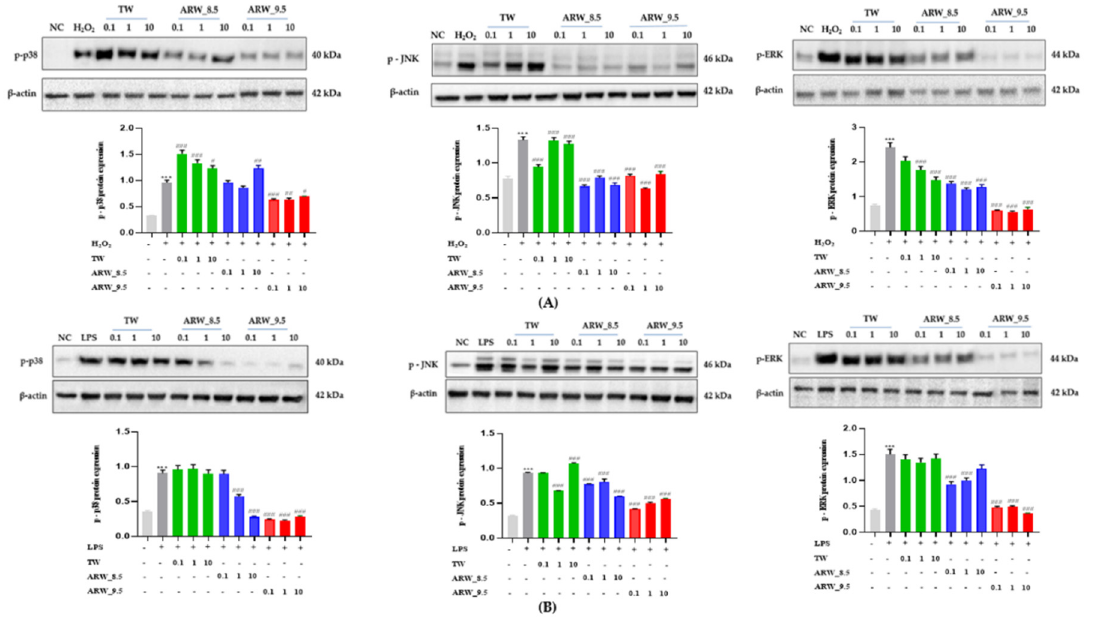
Figure 5. Effect of ARW_8.5 and ARW_9.5 on the expression of MAPK pathway-related proteins (p-p38, p-JNK, and p-ERK) in H 2 O 2 − and LPS-induced RAW 264.7 murine macrophage cells. Cytotoxicity was induced by H 2 O 2 (200 µ mol/mL for 2 h) ( A ) and LPS (10 µ g/mL for 24 h) ( B ), and the cells were treated with ARW (pH 8.5 and pH 9.5) at concentrations of 0.1%, 1%, and 10%. Data are expressed as the mean ± standard error of the mean (SEM) of the fold change relative to the control ( n = 3). Statistical significance was analyzed with two-way ANOVA. ( − ): non-treatment, (+): treatment. ***, p < 0.001 vs. normal control. # , p < 0.05; ## , p < 0.01, and ### , p < 0.001 vs. Con/H 2 O 2 or Con/LPS. Abbreviations: ARW, alkaline reduced water; TW, tap water; H 2 O 2 , hydrogen peroxide; LPS, lipopolysaccharide; MAPK, mitogen-activated protein kinase; p-p38, phospho-p38; (p-JNK), phospho-c-Jun amino-terminal kinases; p-ERK, phospho-extracellular signal-regulated kinases; Con,